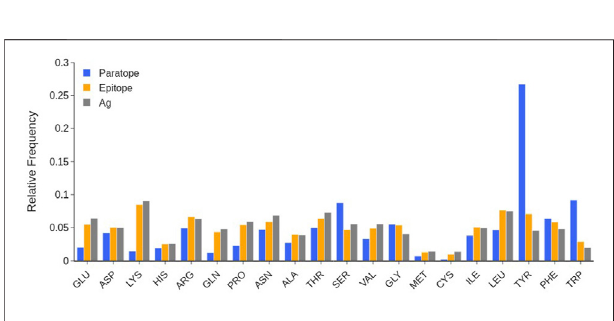
FIGURE 4 | Comparison between the amino acid composition of paratope (blue), epitope (orange), and the entire SES of the antigen (gray). Individualstructuresaretakenfromthatofthecomplex,byrigidremoval.Data calculated over the SabDab database asofMay 2022(1425 structures).